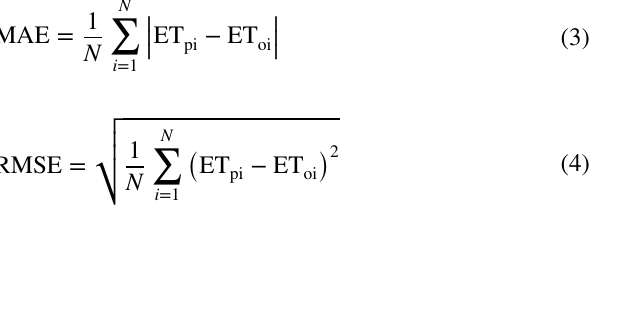
Table 2 The best subset regression analysis for determining the best input combinations at Faisalabad station No. of Variables variables